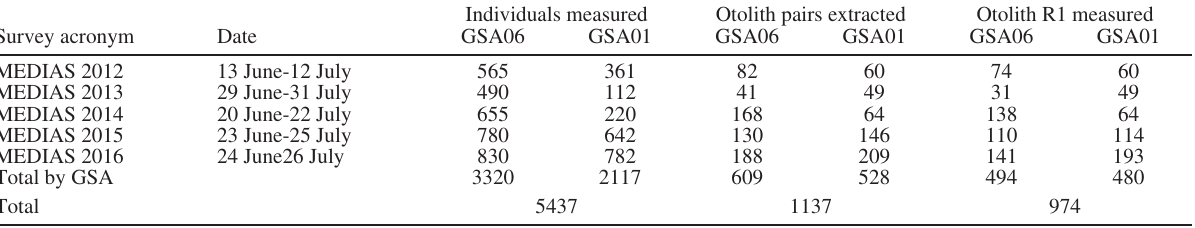
Table 1. – Periods of survey, sample locations (GSA06/GSA01), anchovy individuals measured to the nearest 0.5 cm, otolith pairs extracted and read and otolith R1 measured. Individuals